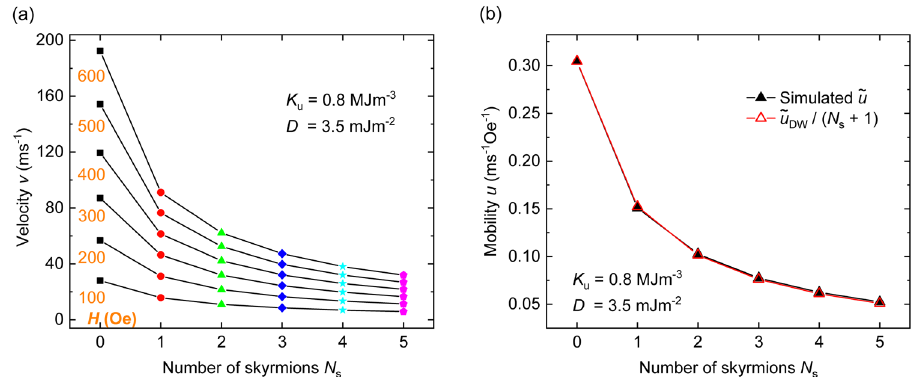
Fig. 4 Ensemble velocity evolution with the number of included skyrmions. a Ensemble velocity versus the number of skyrmions N s at various fi eld strengths. b Ensemble mobility versus N s . Black dots are simulation results and red dots are given by ũ dw / ( N s + 1) with ũ dw representing the mobility of a single domain wall. Lines are guides to eyes. The strengths of perpendicular magnetic anisotropy and Dzyaloshinskii-Moriya interaction are K u = 0.8 MJm − 3 and D = 3.5 mJm − 2 , respectively.